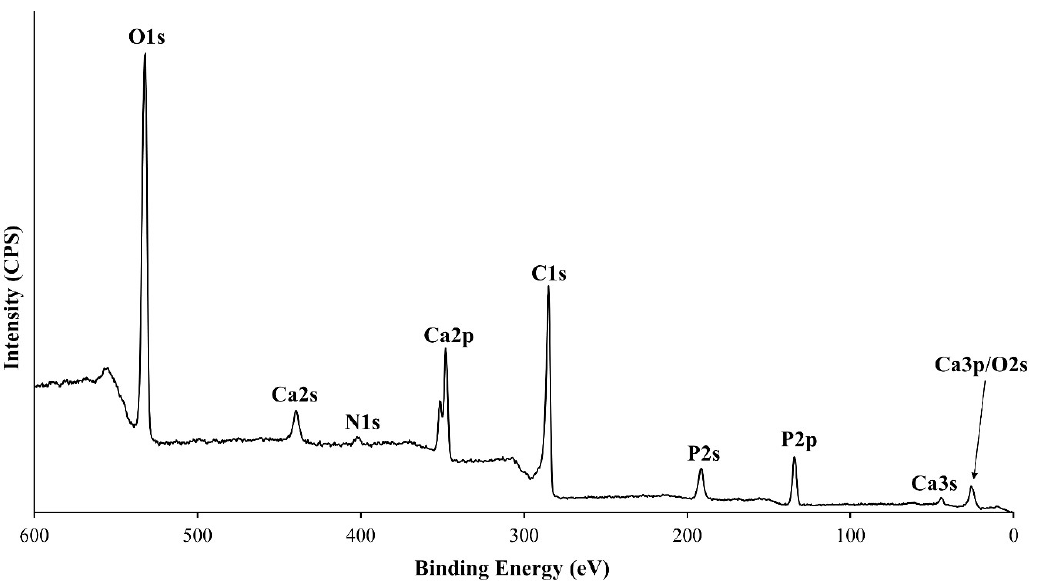
Figure 5. XPS survey scan (0–600 eV) for HA10.